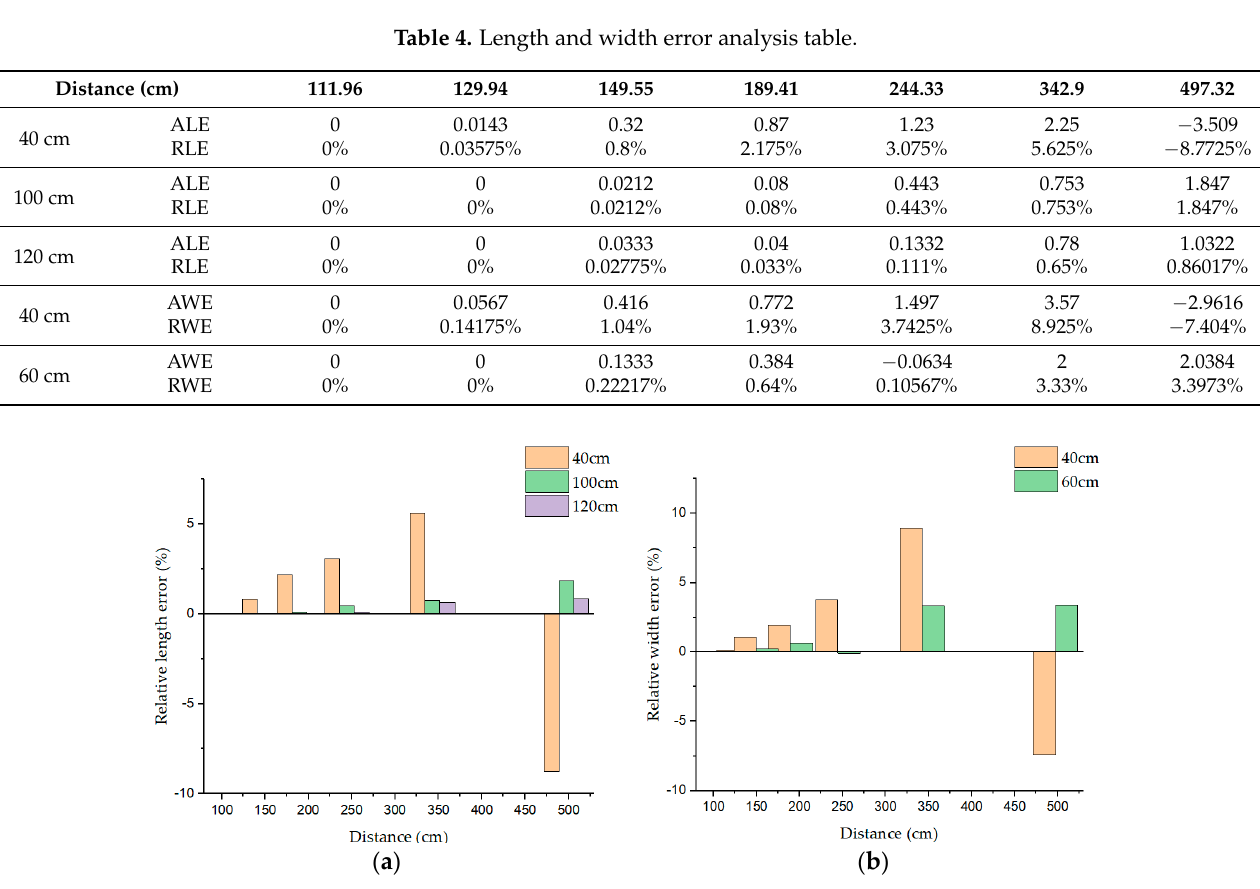
Figure 17. Relative error analysis. ( a ) Length relative error analysis; ( b ) width relative error analysis.